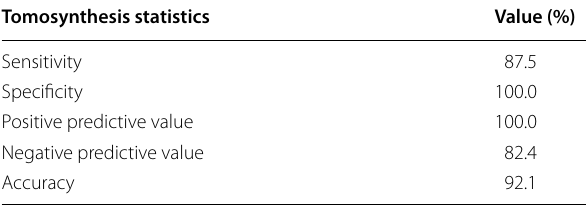
Table 5 Tomosynthesis accuracy measures Tomosynthesis